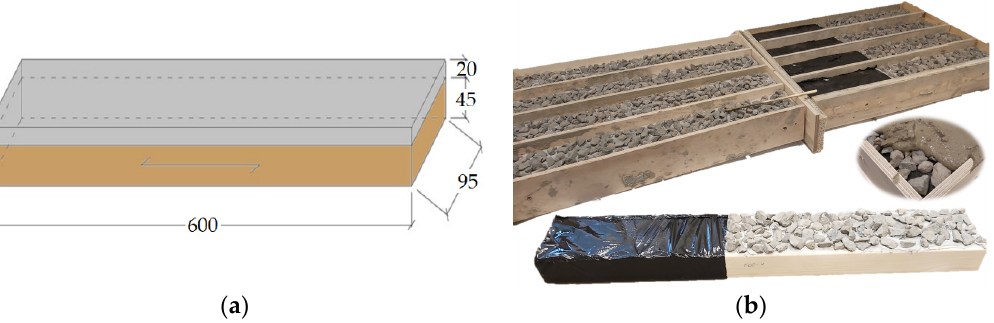
Figure 1. ( a ) Specimen dimensions; ( b ) specimens’ placement in the molds and TCC specimen with wrapped 40% of the specimen end in a PE film to ensure the defect in the timber ‐ to ‐ concrete adhe ‐ sive